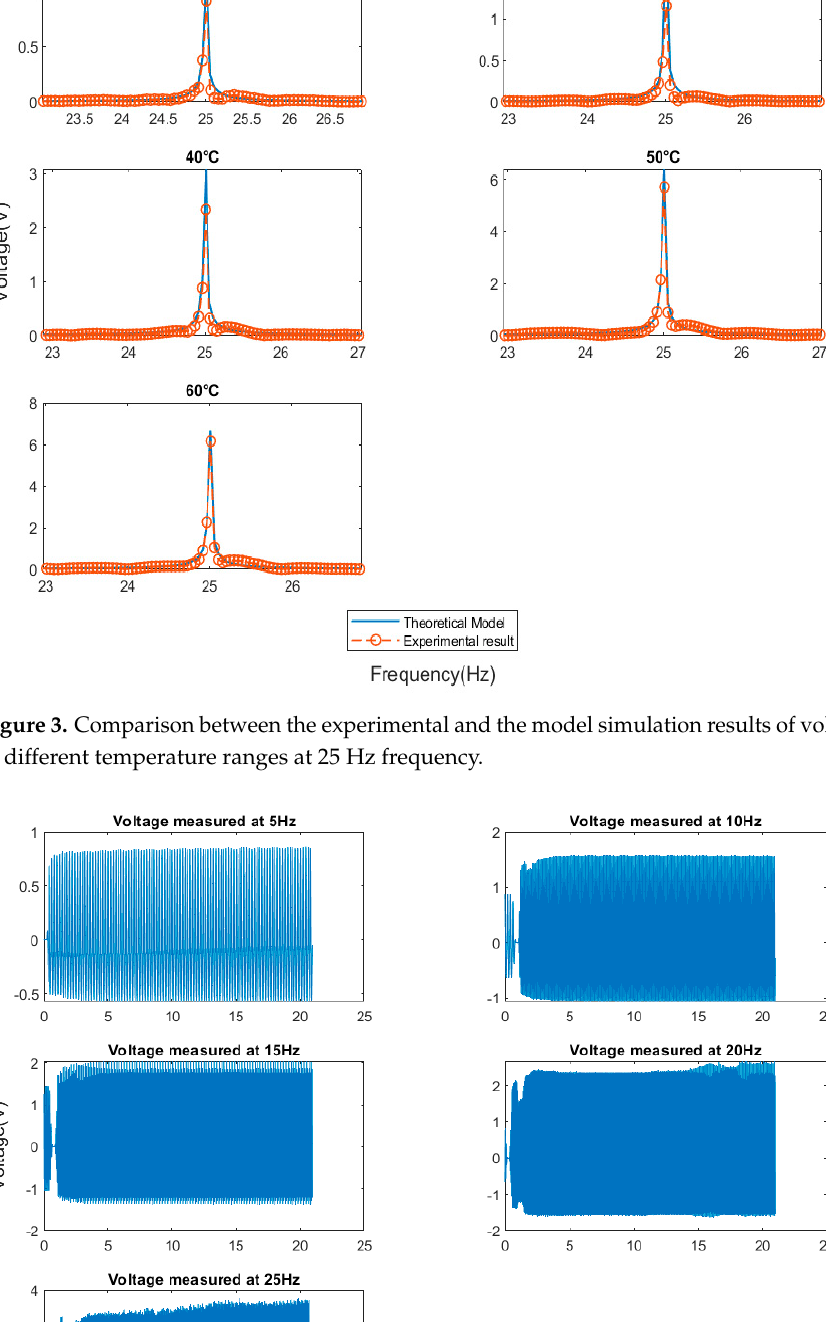
Figure 5. Frequency domain voltage measurement at various temperatures.